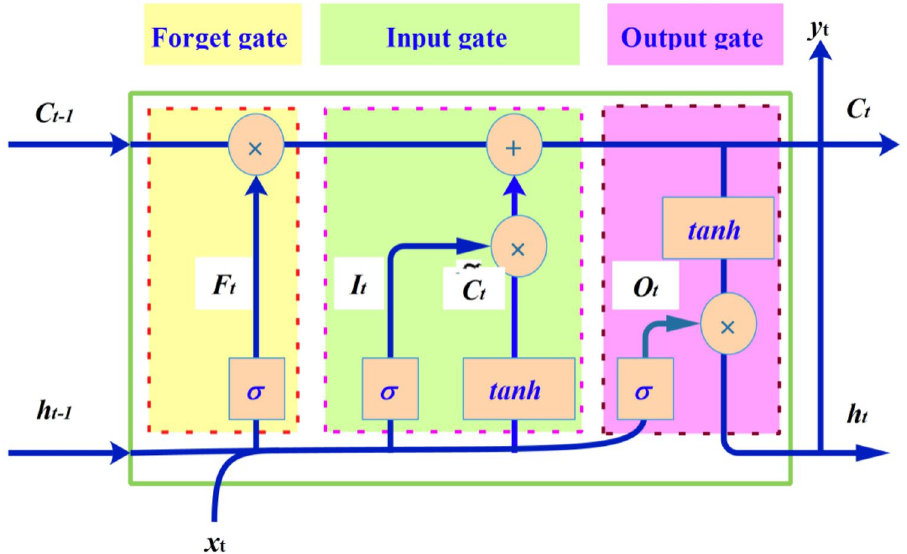
Figure 2. The internal structure of LSTM